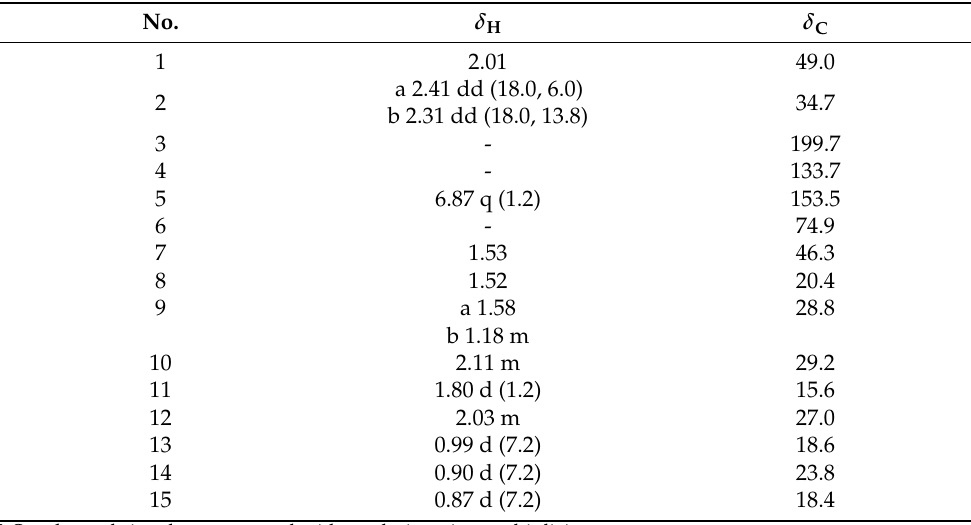
Table 1. 1 H and 13 C NMR data of 1 (in CDCl 3 δ , J in Hz) a .